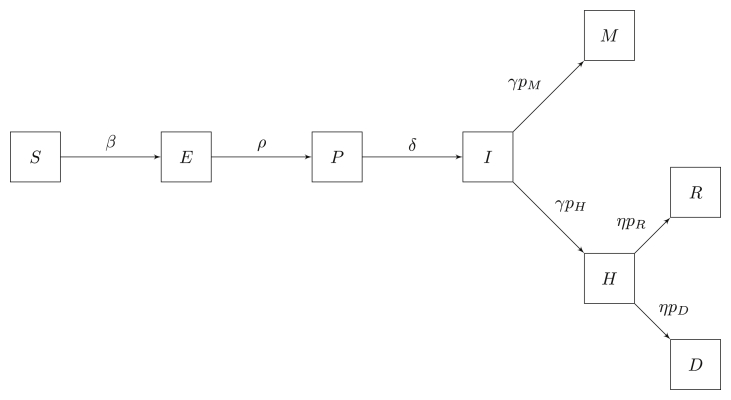
Compartmental model for disease dynamics within a care-home. We extend a deterministic SEIR model to include compartments for prodromal (infectious) cases (P), mildly symptomatic cases that recover without requiring hospitalisation (M), cases that do require hospitalisation and are removed from the care home (H), cases that die in hospital (D) and cases that recover in hospital (R).